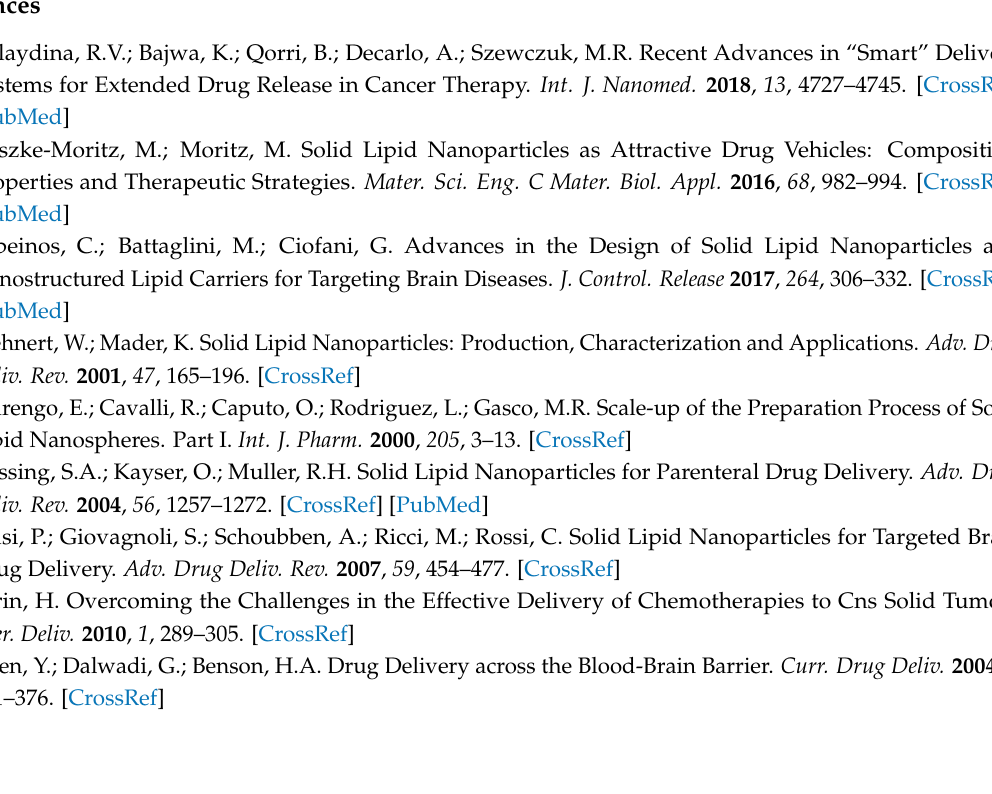
Figure S1: TEM micrographs of the SLN under study, Figure S2: Particle size, polydispersity index and ζ -potential values of SLN with different initial ATRA amounts, Figure S3: Determination of ATRA entrapment efficiency (EE) in different SLN suspensions and Figure S4: Particle size, polydispersity index and ζ -potential values of SLN with 1 mg of initial ATRA, with or without